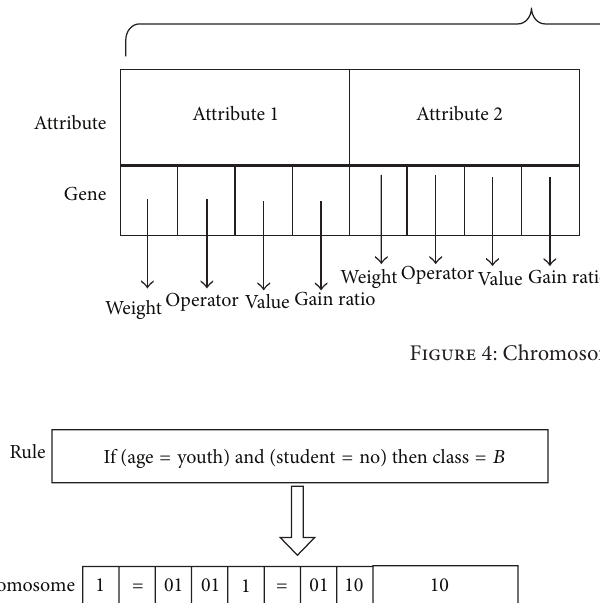
Figure 5: A simple example for rule